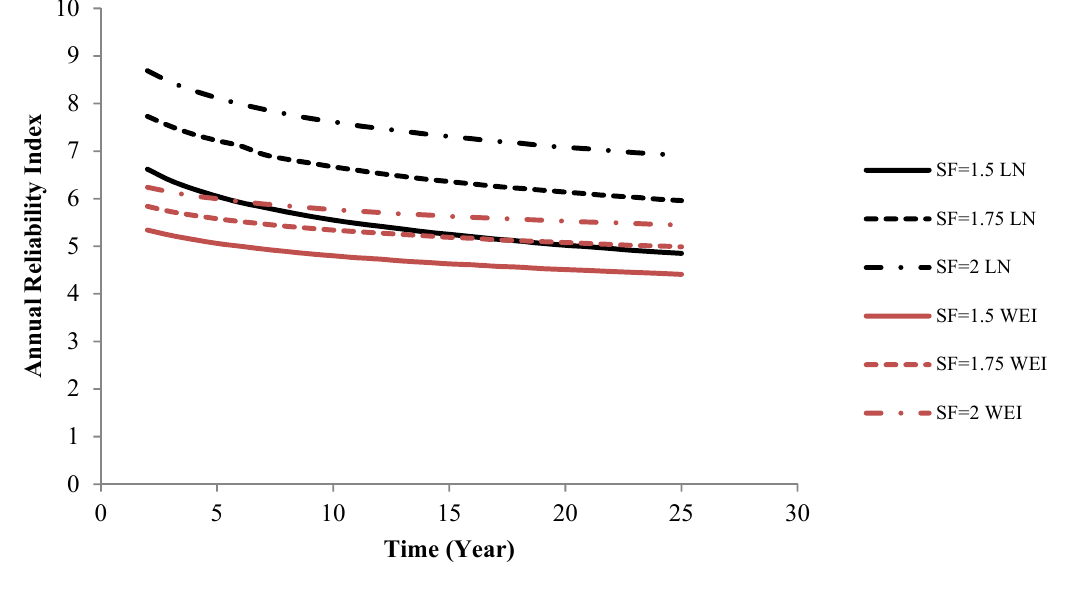
 = 1.5, 1.75 and 2.0 using the m